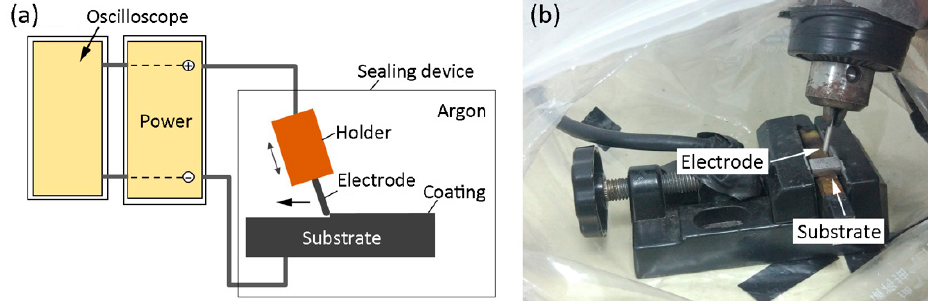
Figure 1. Schematic diagram of electro-spark deposition system ( a ); and the experimental setup ( b ).